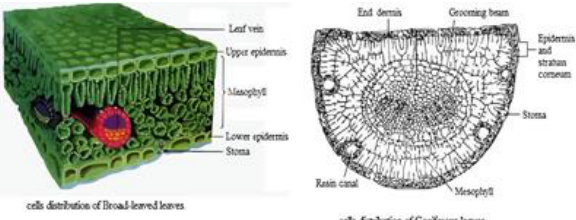
Figure 1. Arrangement of